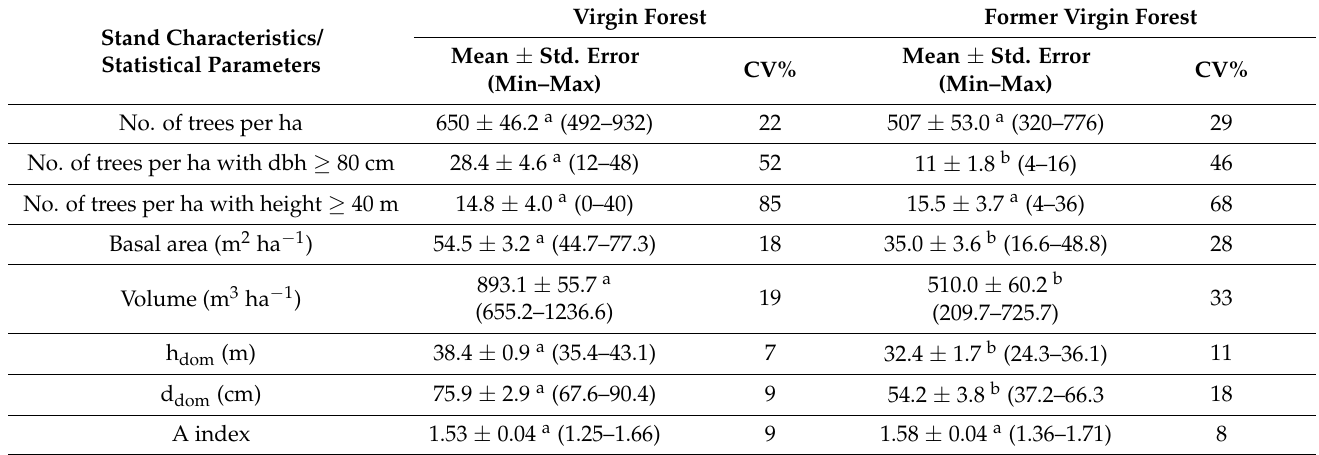
Table 1. Basic statistical parameters for the stand characteristics of the investigated VF and FVF silver fir–beech forests. Abbreviations used: h dom = top height of 100 tallest trees, d dom = mean diameter of 100 thickest trees, CV = coefficient of variation. Different letters represent the significant differences between the means of stand characteristics using ANOVA–Tukey’s test.